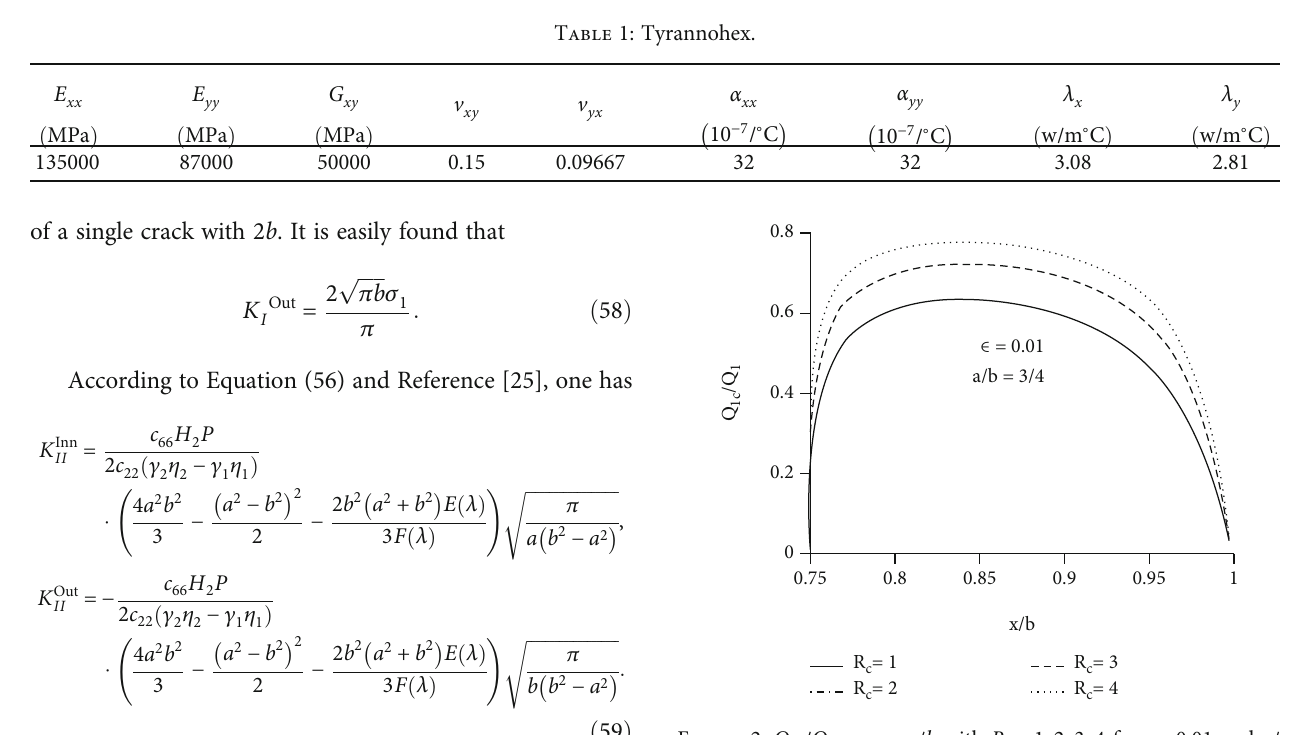
Figure 2: Q b = 3/4